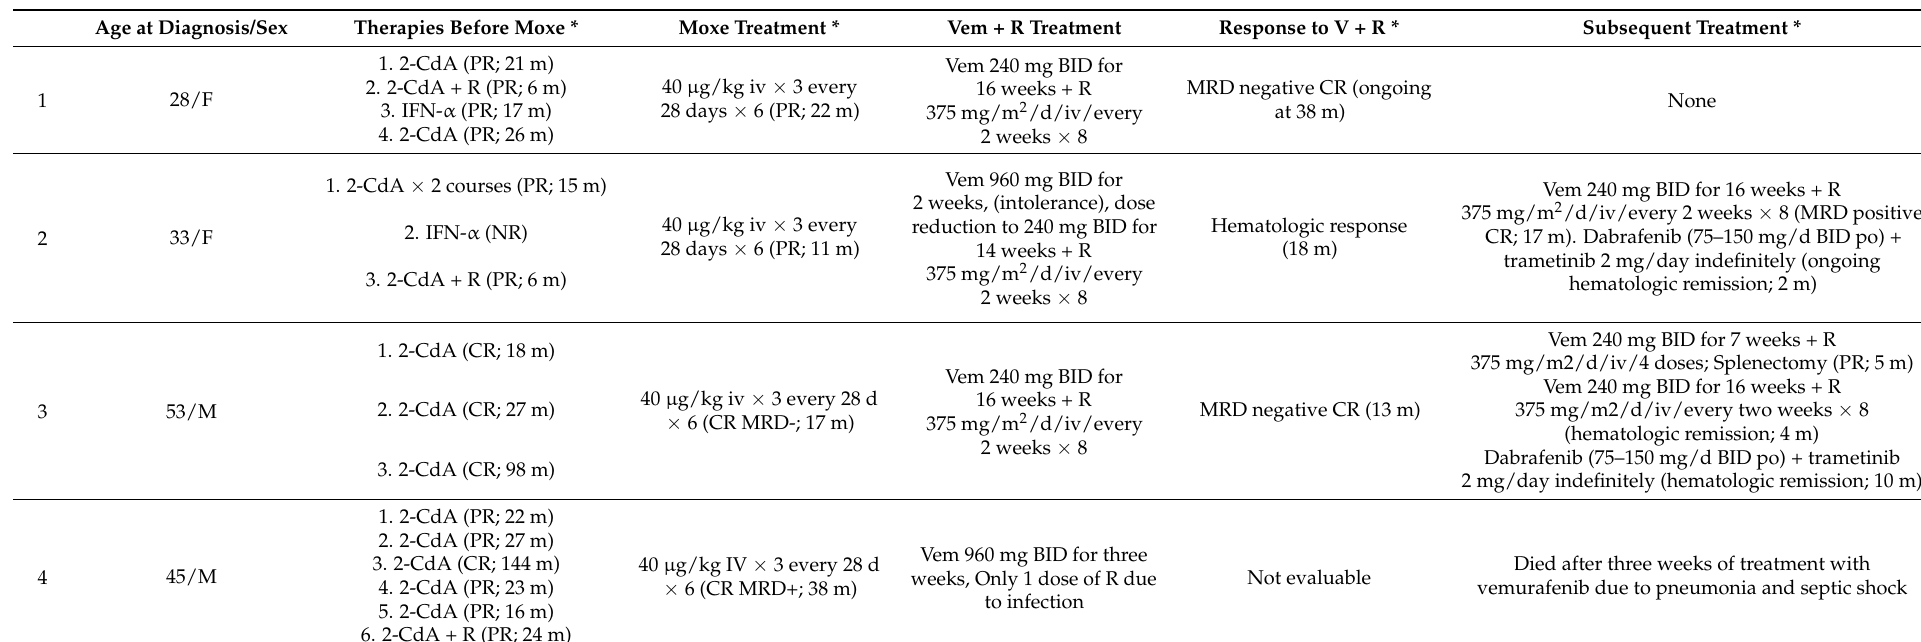
Table 1. Patient characteristics and treatment